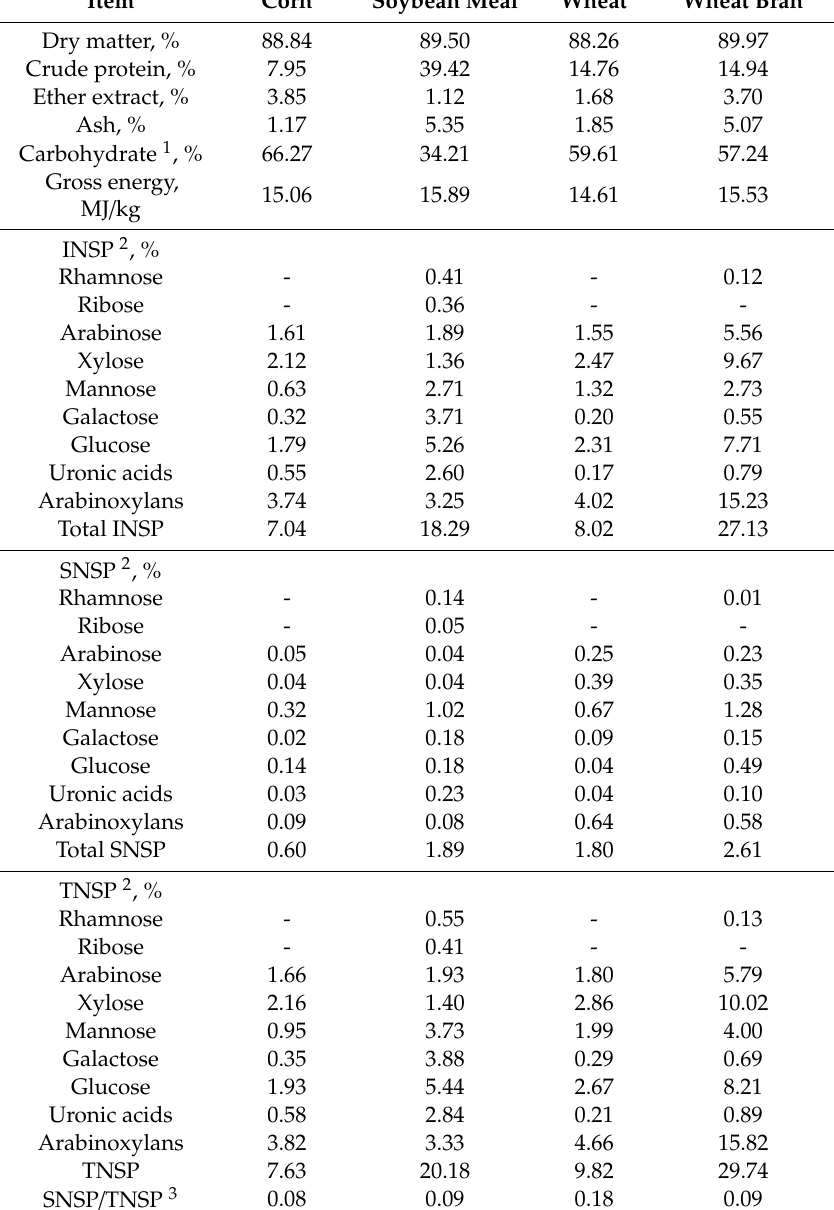
Table 1. Analyzed nutrient composition and energy of feed ingredients, as-fed basis. Item